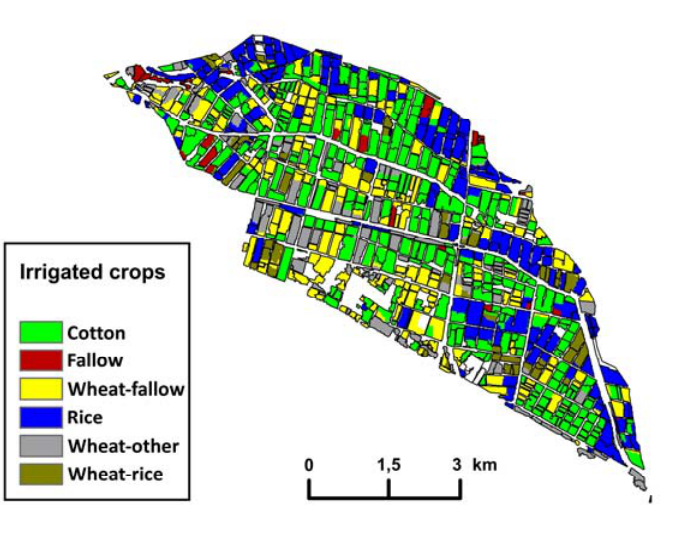
Figure 9. Per-field crop map of the WUA Jayhun (close to the Amu Darya River) derived from bi-temporal ASTER